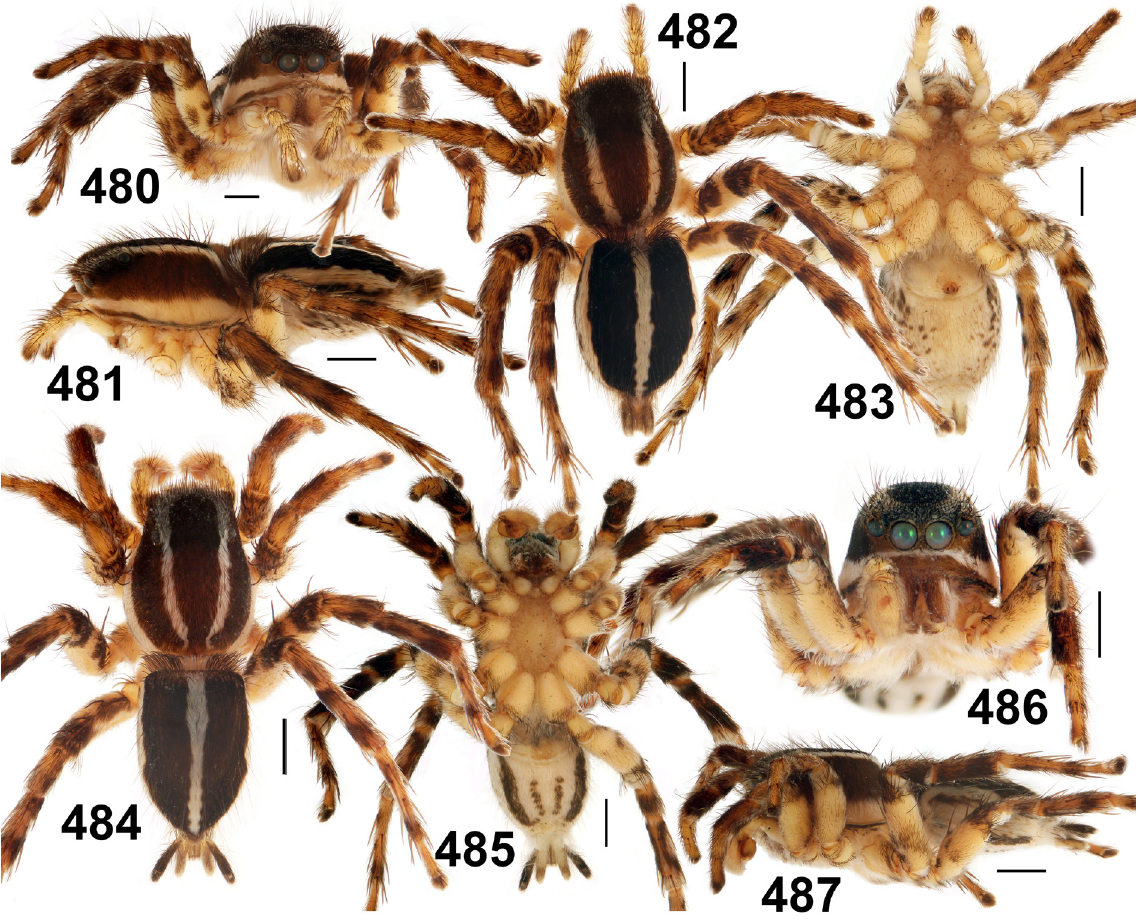
Figs 480–487. Stenaelurillus termitophagus (Wesołowska & Cumming, 1999) comb. nov. from South Africa (Doompoort, NCA 2010/4945), general appearance. 480–483 . ♀. 484–487 . ♂. Scale bars: